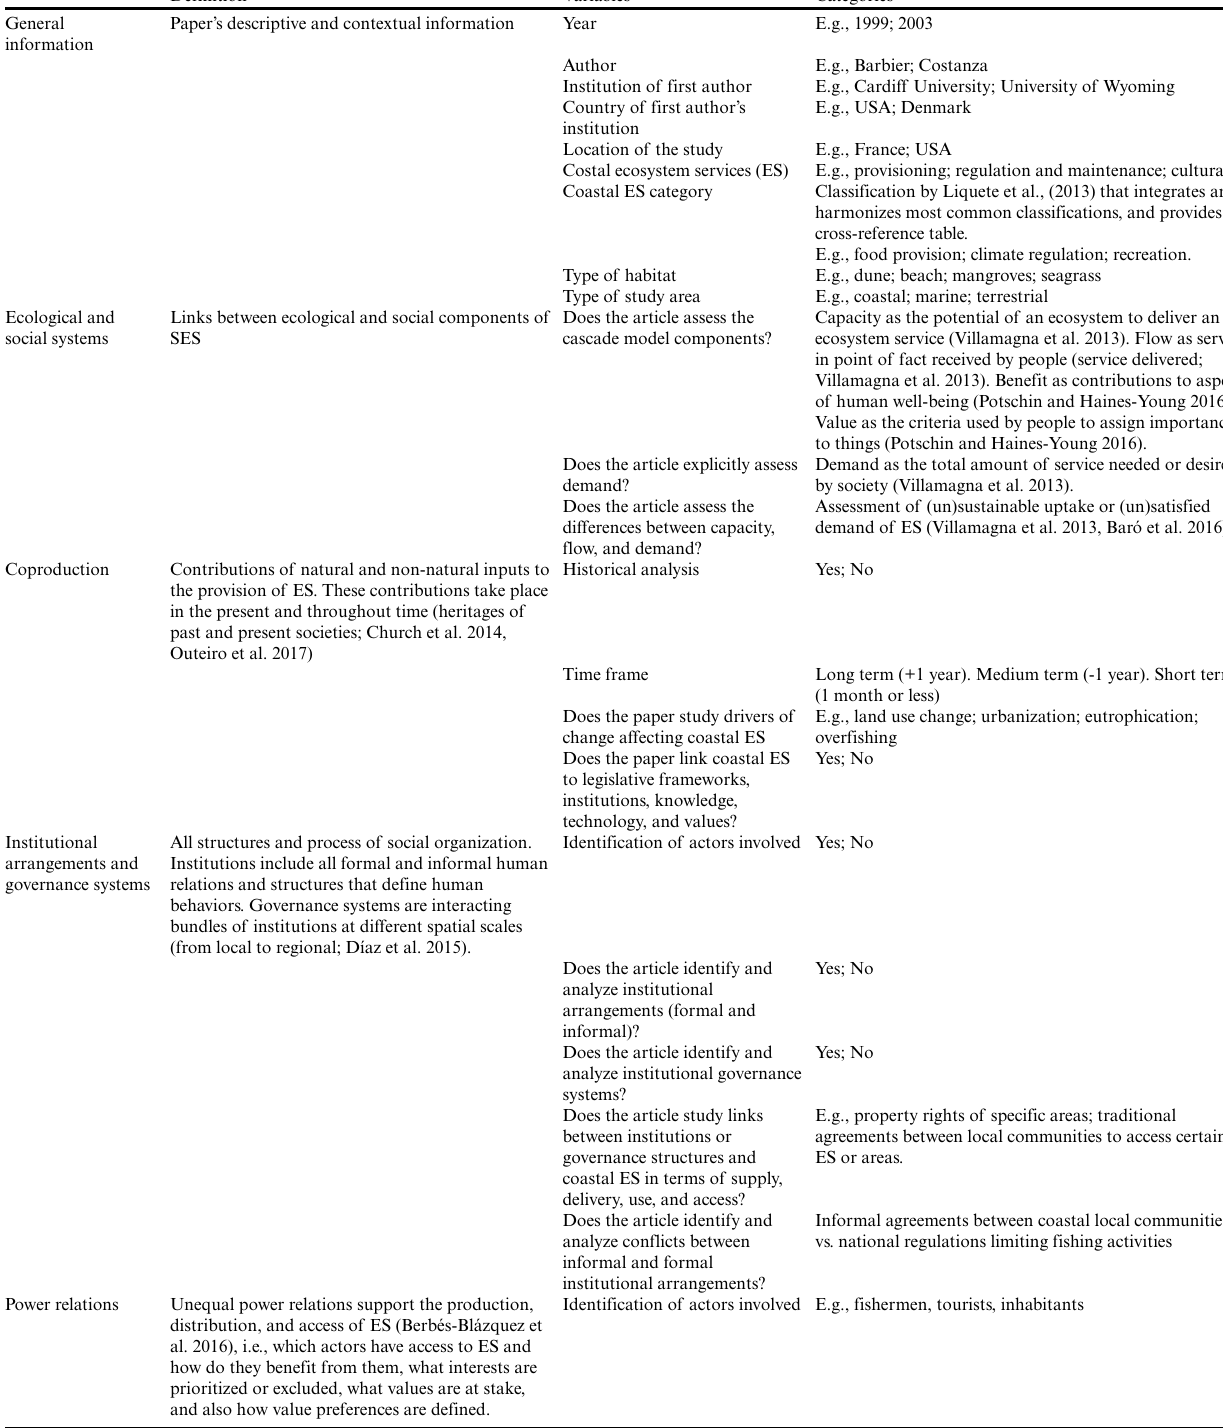
Table 1 . Data variables and categories for data